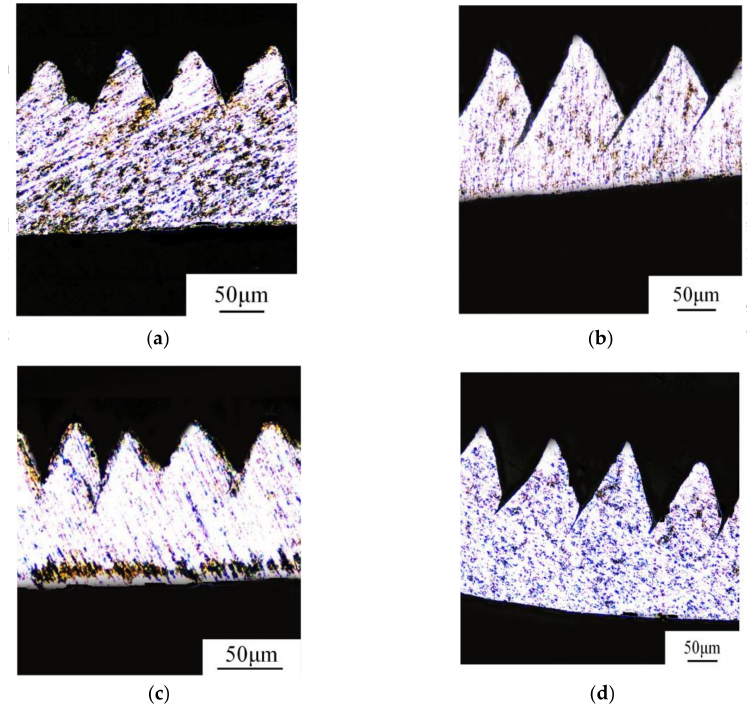
Figure 6. Saw-tooth chips: ( a ) v c = 50 m/min, f r = 0.2 mm/r, a p = 0.4 mm; ( b ) v c = 450 m/min, f r = 0.2 mm/r, a p = 0.4 mm; ( c ) f r = 0.1 mm/r, v c = 150 m/min, a p = 0.4 mm; ( d ) f r = 0.3 mm/r, v c = 150 m/min, a p = 0.4 mm.